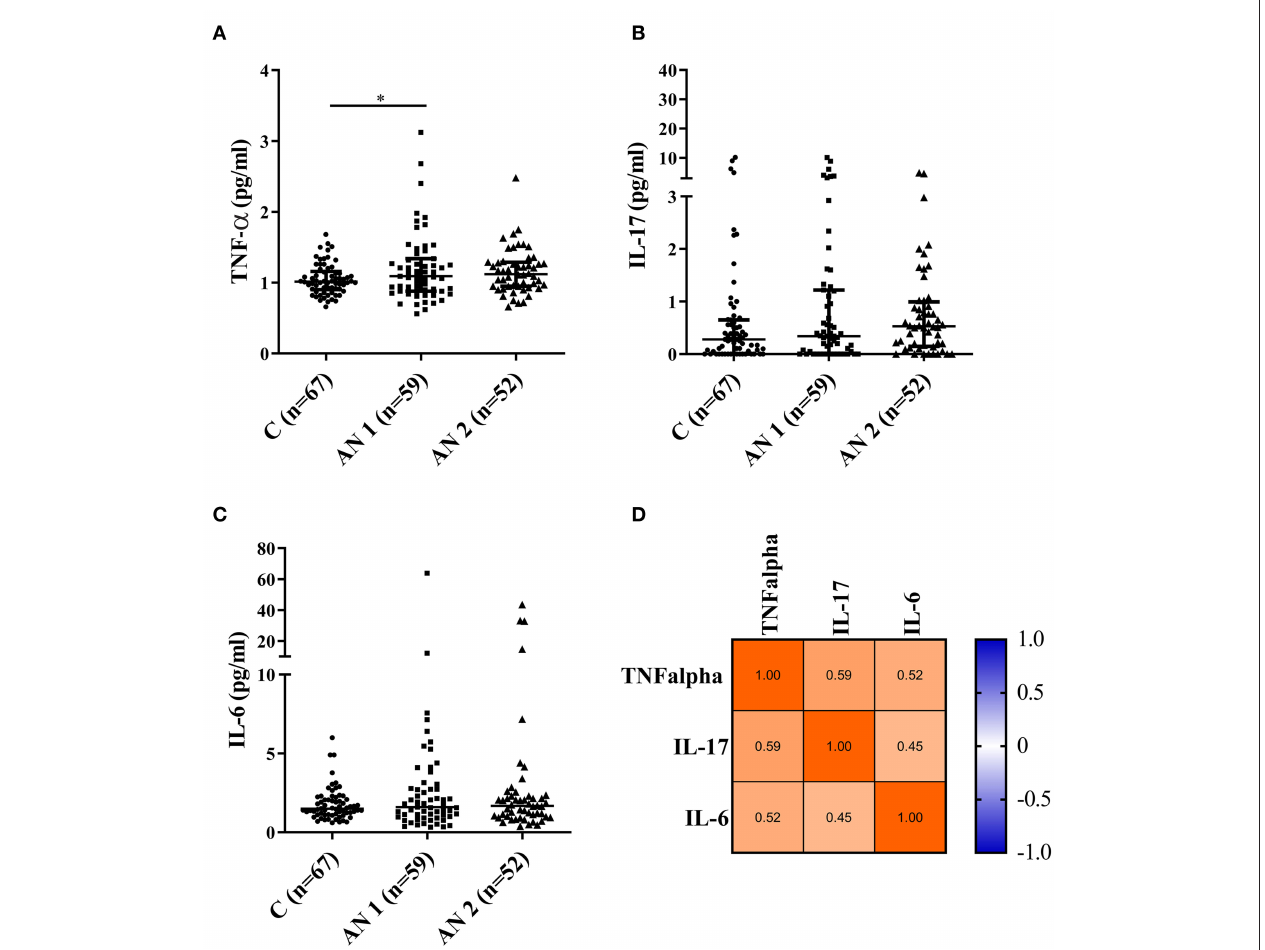
FIGURE 4 | Pro-inflammatory cytokine levels measured in healthy controls, patients at hospital admission (AN1), and their discharge (AN2). (A–C) Cytokine levels (TNF- α , IL-17, and IL-6, respectively). Kruskal-Wallis test with Dunn’s multiple comparisons test were applied ( * P < 0.05). The multiple correlations predicted the variables dependency (TNF- α , IL-17, and IL-6; D